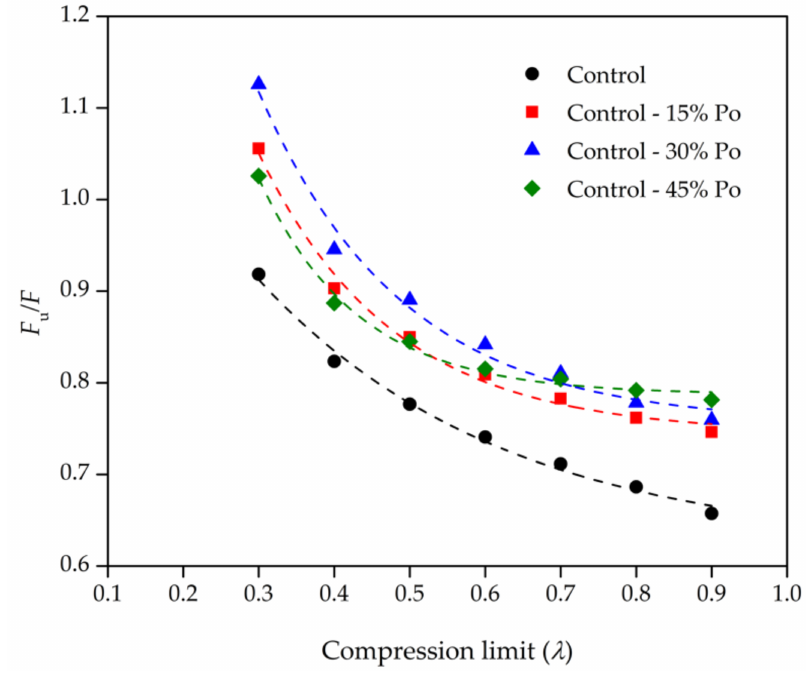
Figure 8. Ratios of the internal energy force ( F u ) to the compression force ( F ) as a function of the compression limit ( λ ) for various rubber foams. The scatter on the results is on the order of the size of the data points.